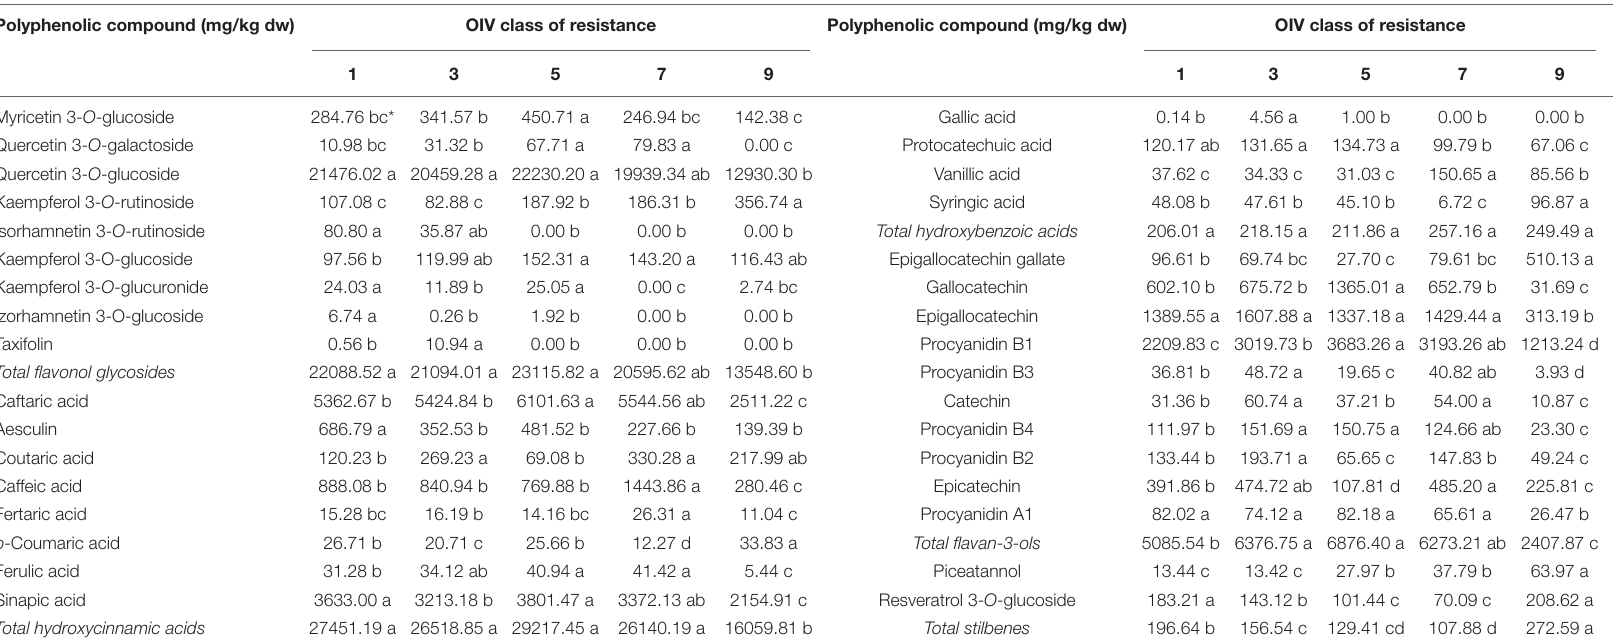
TABLE 2 | The differences between OIV classes of resistance to P. viticola in the content of polyphenolic compounds (mg/kg dw) in the young leaves. Polyphenolic compound (mg/kg